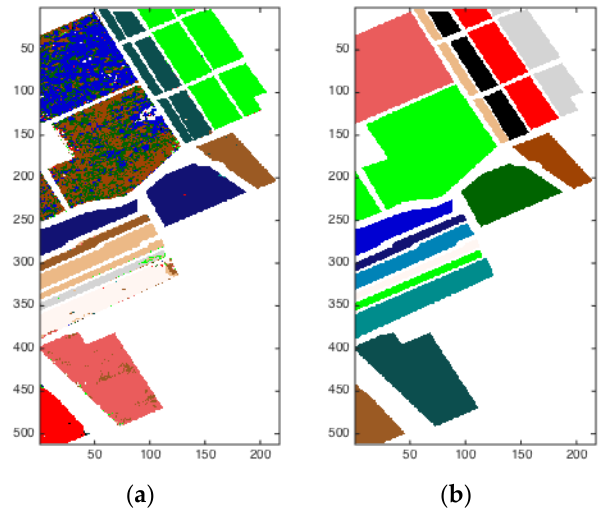
Figure 10. Sanilas Image. ( a ) Classification map based on DBN and SOM. ( b ) Reference data.